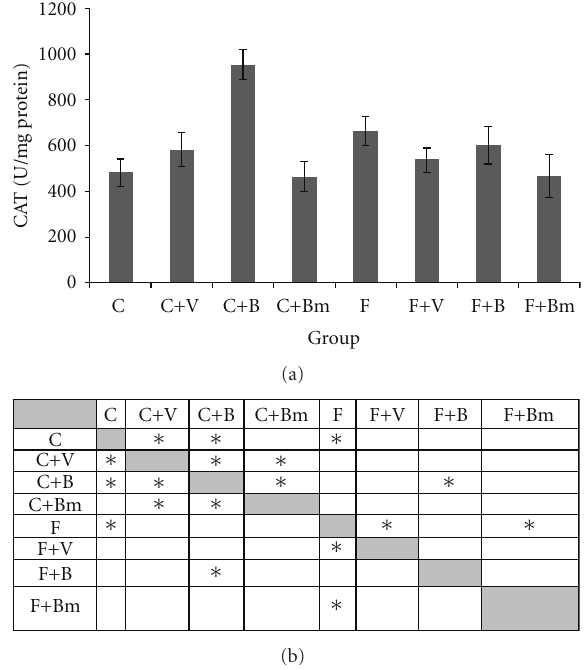
Figure 8: E ff ects of vanadium complex V, B, and Bm on plasma CAT of Wistar rats. Data are presented as mean ± SD. for n = 6. (b) Statistical di ff erences between groups P <